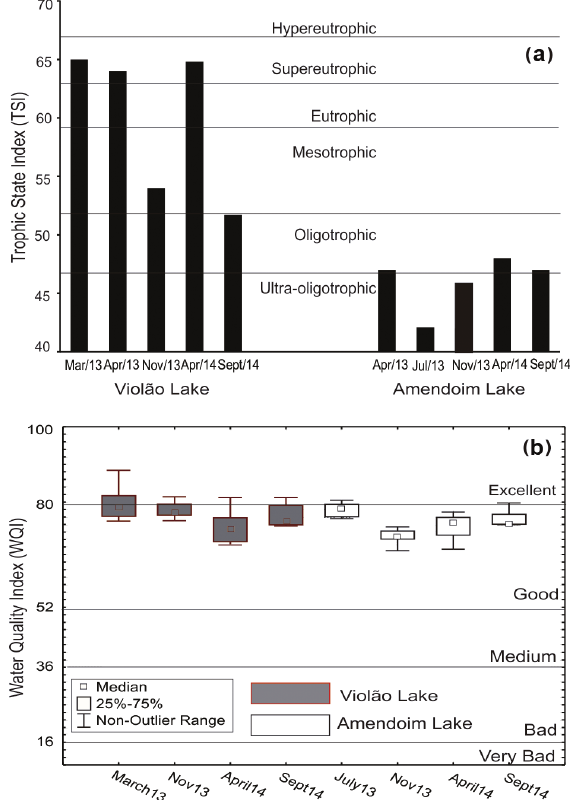
Figure 5 - a) Trophic State Index (TSI) of the Violão and Amendoim lakes during wet and dry period of 2013-2014; b) Water quality index (WQI) of the of the Violão and Amendoim lakes in different climatic period in